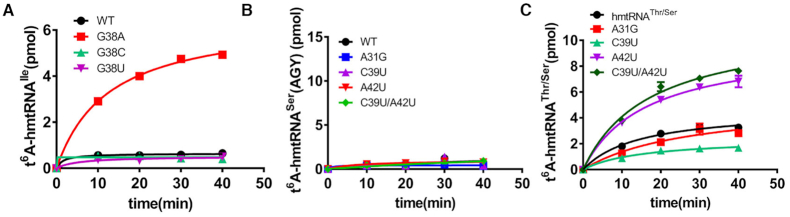
Sequences of hmtRNAIle and hmtRNASer(AGY) are fine-tuned for t6A modification. (A) t6A modification levels of hmtRNAIle (black filled circles) and mutants G38A (red filled squares), G38C (cyanine filled triangles) and G38U (magenta filled inverted triangles) by YrdC/OSGEPL1. (B) t6A modification levels of hmtRNASer(AGY) (black filled circles) and mutants A31G (blue filled squares), C39U (magenta filled triangles), A42U (red filled inverted triangles) and C39U/A42U (green filled diamonds) by YrdC/OSGEPL1. (C) t6A modification levels of hmtRNAThr/Ser (black filled circles) and mutants A31G (blue filled squares), C39U (cyanine filled triangles), A42U (magenta filled triangles) and C39U/A42U (dark green diamonds) by YrdC/OSGEPL1.